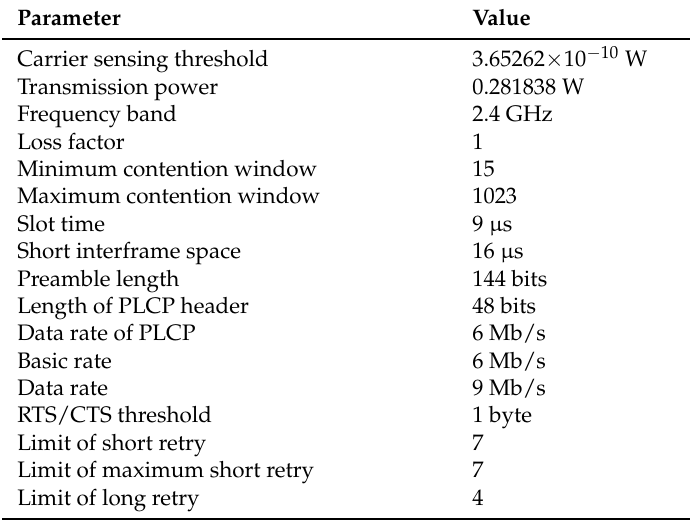
Table 1. Simulation parameters of physical and MAC layers in